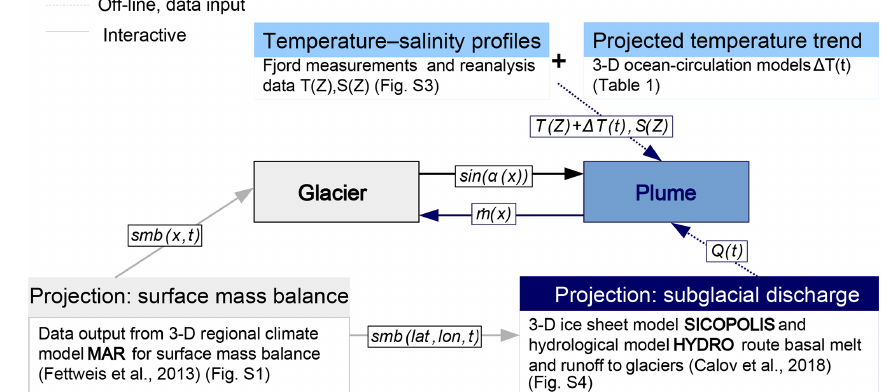
Figure 2. Visualization of the experimental setup. In the center the coupled glacier–plume model exchange information on the glacier geometry (sin (α) ) and the calculated submarine melt rate ( ˙ m ) on every time step for every glacier grid point x . To force the coupled model for global warming (RCP8.5), changes in SMB (smb (x,t) ), ocean temperature ( T (Z) + (cid:49)T (t) ) and subglacial discharge ( Q(t) ) are considered via data input. While the SMB changes act on the glacier part, the changes in subglacial discharge and ocean temperature are used to recalculate the submarine melt rate by the plume part of the model. The future evolution of subglacial discharge and ocean temperature is prescribed firmly in the data sets (off-line) that force the plume part, whereas changes in SMB are corrected for the surface elevation feedback and therefore regard changes in the ice surface height interactively. SMB is derived from MAR data (Fettweis et al., 2013), also used to derive the subglacial discharge for each glacier by Calov et al.